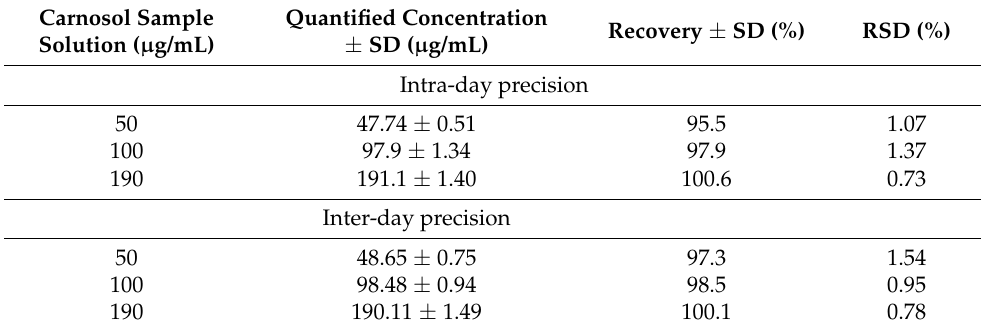
Table 4. Precision parameters expressed as RSD % ( n =